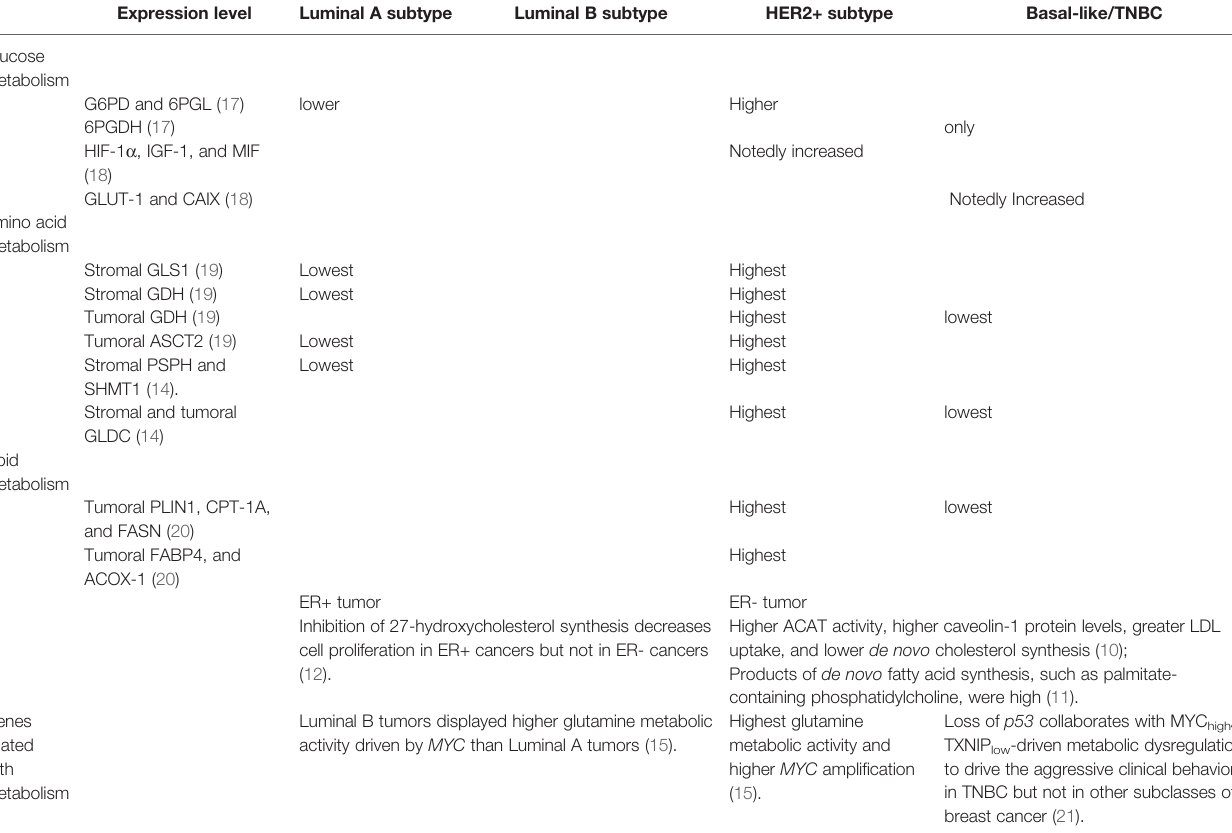
TABLE 1 | Metabolic differences in different breast cancer